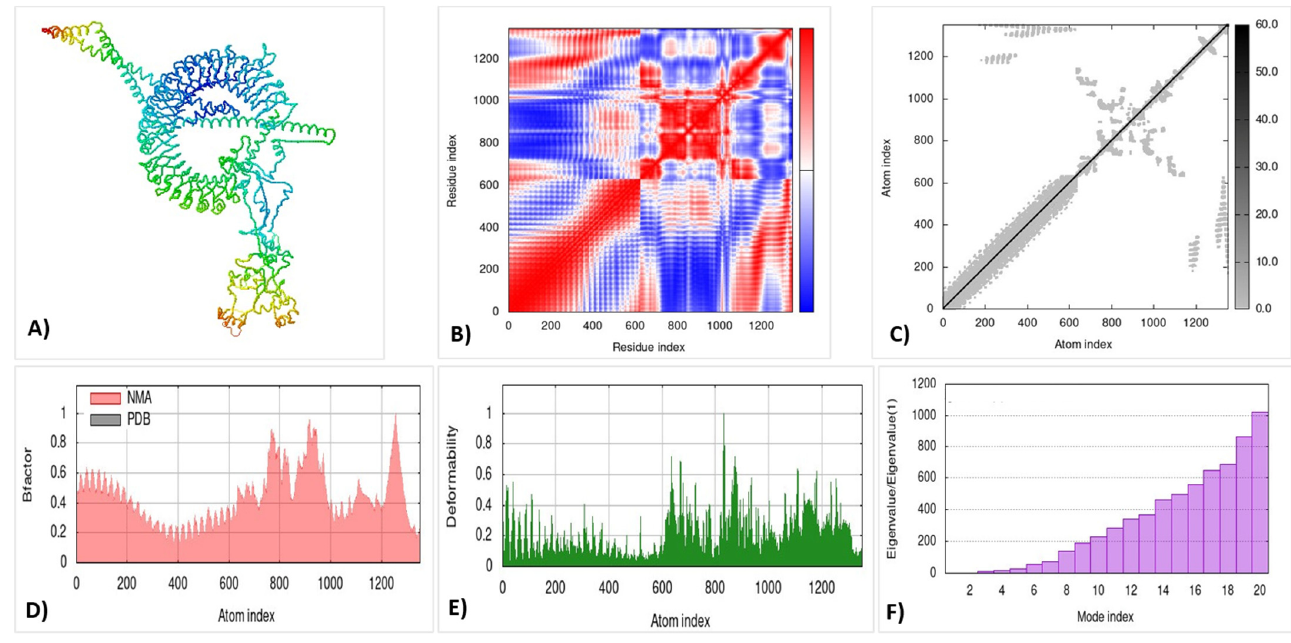
Figure 5. The receptor–ligand interactions, normal mode analysis, and molecular dynamics simula- tion: ( A ) vaccine–TLR3 docked complex using the ClusPro server; ( B ) covariance matrix; ( C ) elastic network model using the iMODS server; ( D ) B-factor graph; ( E ) deformability graph; ( F ) Eigenvalue of the vaccine–TLR4 complex.